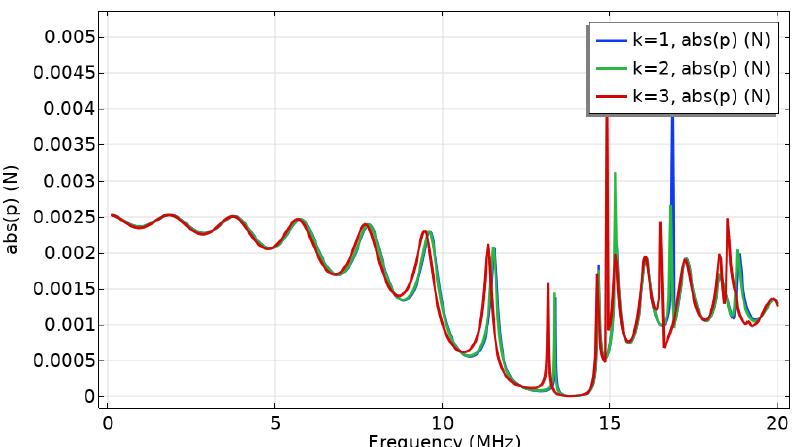
Figure 7. Rough frequency domain analysis of a 1 mm channel at 293.15 K (k = 1, 2, 3 correspond to the liquid sound velocity = 1500, 1490, 1420 m/s).